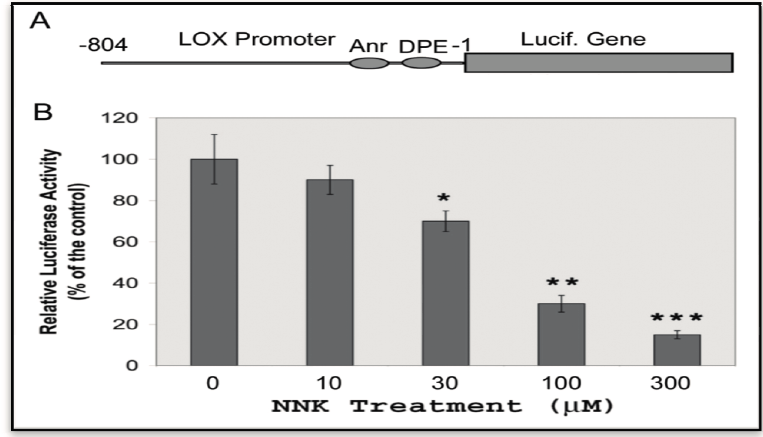
Figure 5. Inhibition of LOX promoter activities in NNK-treated cells. ( A ) Schematic representation of LOX promoter-reporter chimera with the Inr-DPE core promoter. ( B ) NNK inhibition of LOX promoter activities in transfected cells. RFL6 cells were transiently co-transfected with the Prom-804 construct and the pRL-TK vector, an internal control, then treated with NNK at indicated concentrations for 48 h. Luciferase activities in cell lysates were measured by luminometry. Firefly luciferase activities elicited by the LOX promoter were normalized to Renilla luciferase activities derived from the pRL-TK vector and expressed as relative luciferase activities as instructed by manufacturer